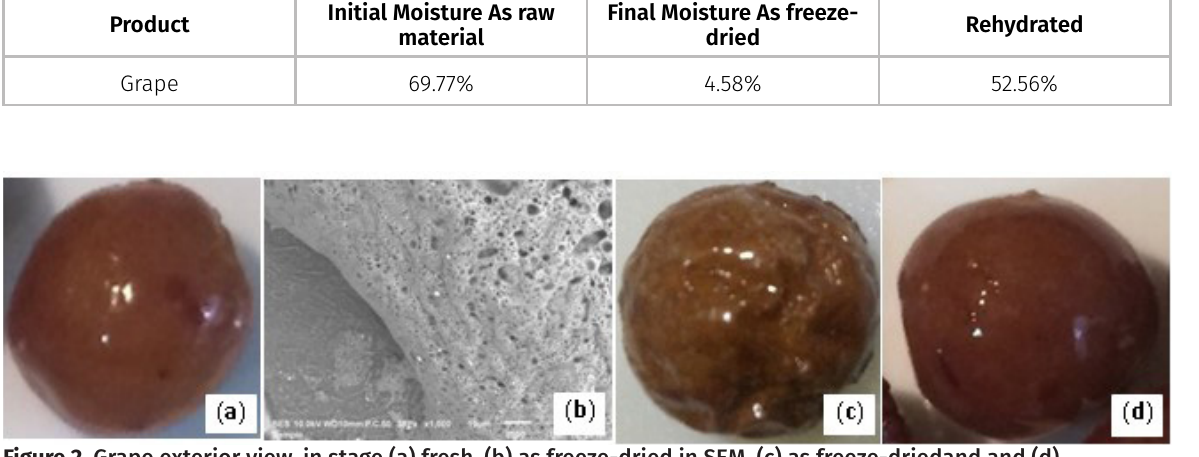
Figure 2. Grape exterior view, in stage (a) fresh, (b) as freeze-dried in SEM, (c) as freeze-driedand and (d) rehydrated.